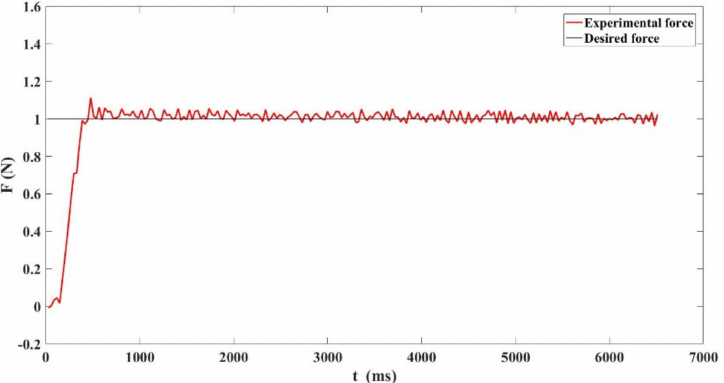
Figure 9. Robotic magnetorheological polishing force response at 1N without disturbance.